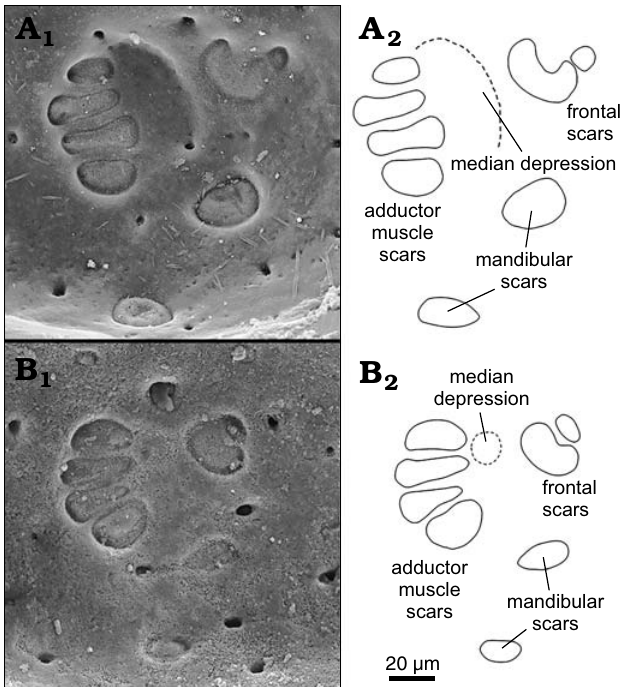
Fig. 4. Comparison of muscle scars of Dolocythere Mertens, 1956 and Minyocythere gen. nov. A . Dolocythere rara Mertens, 1956 from Borehole Lingen 196, 697–704 m, NW Germany, Lower Albian. Paratype, BGR T.-K. 1300 (Mertens Collection, Hannover), female left valve in internal view. B . Minyocythere angulata sp. nov. from Borehole Hambühren WA2, 203 m, NW Germany, Upper Aalenian (Braun Jura β ). Paratype, SMF Xe 23738, female left valve in internal view. A 1 , B 1 , photographs; A 2 , B 2 , ex- planatory